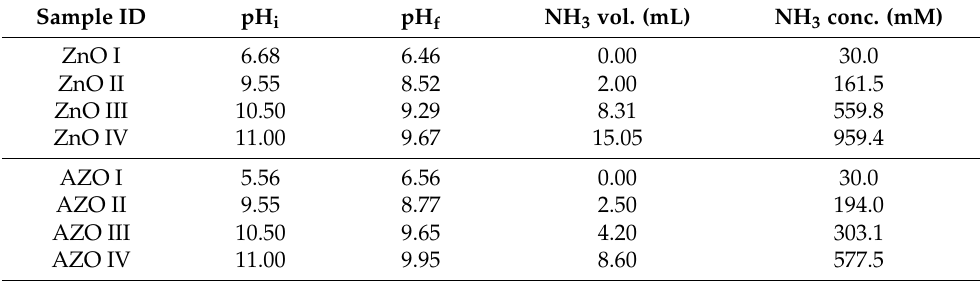
Table 1. Conditions used during the experiments to prepare ZnO and AZO NRs grew on glass substrates (pH i : initial pH, pH f : final pH after growth, NH 3 volume added initially for specific pH, Concentration of NH 3 resulted from HMTA and added NH 3